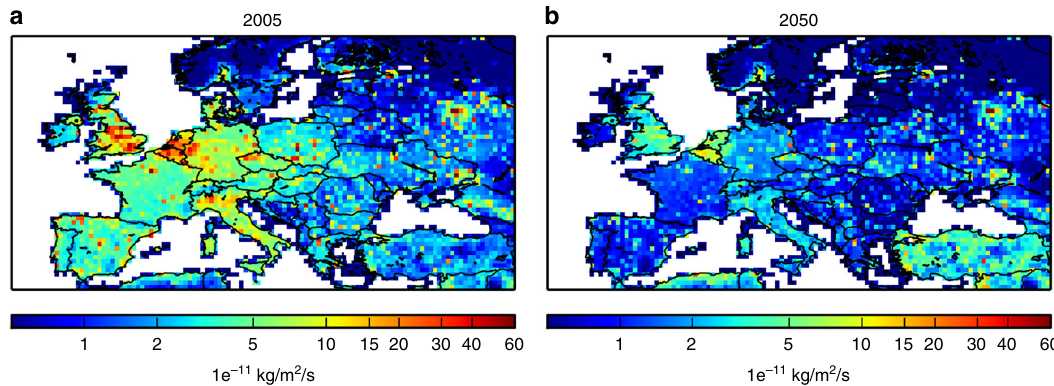
Fig. 4 Evolution of ECLIPSE-V4a NO x emissions between 2005 and 2050. ECLIPSE-v4a NO x emissions in a 2005 and in b 2050. Units are 1e − 11 kg/m 2 /s. This fi gure has been generated using the Matplotlib library for the Python programming language (https://matplotlib.org/)